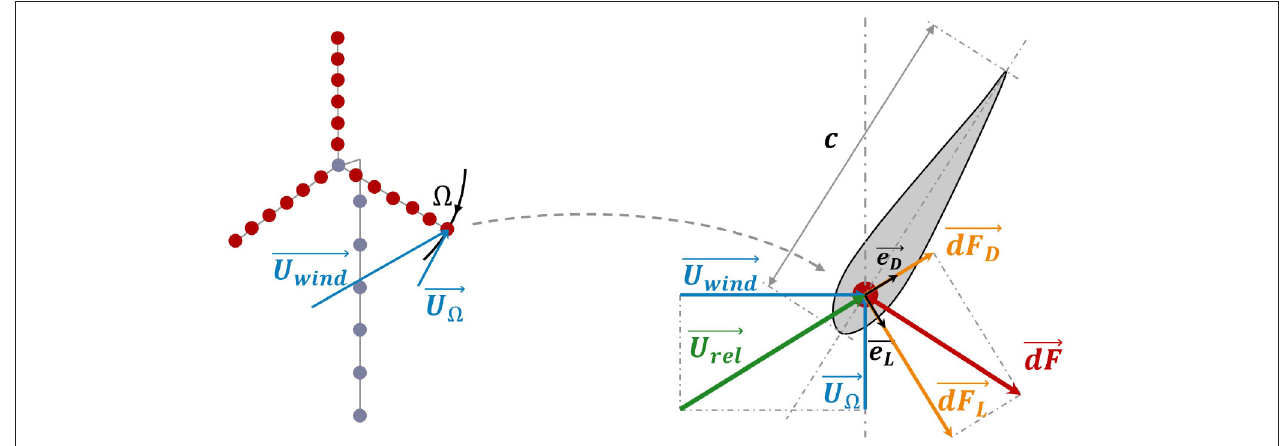
FIGURE 1 | 2D blade element velocities and